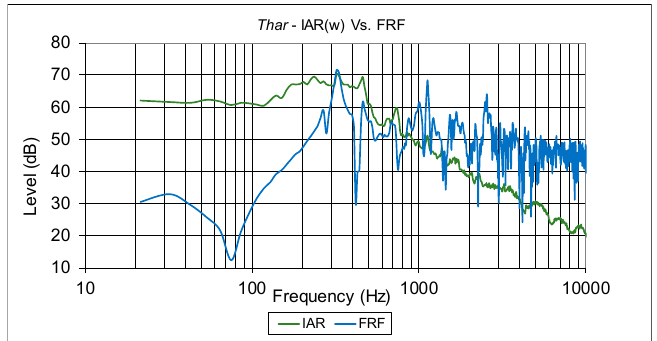
Figure 4. Intensity of acoustic radiation (IAR) compared with the frequency response function (FRF) for the Persian thar.